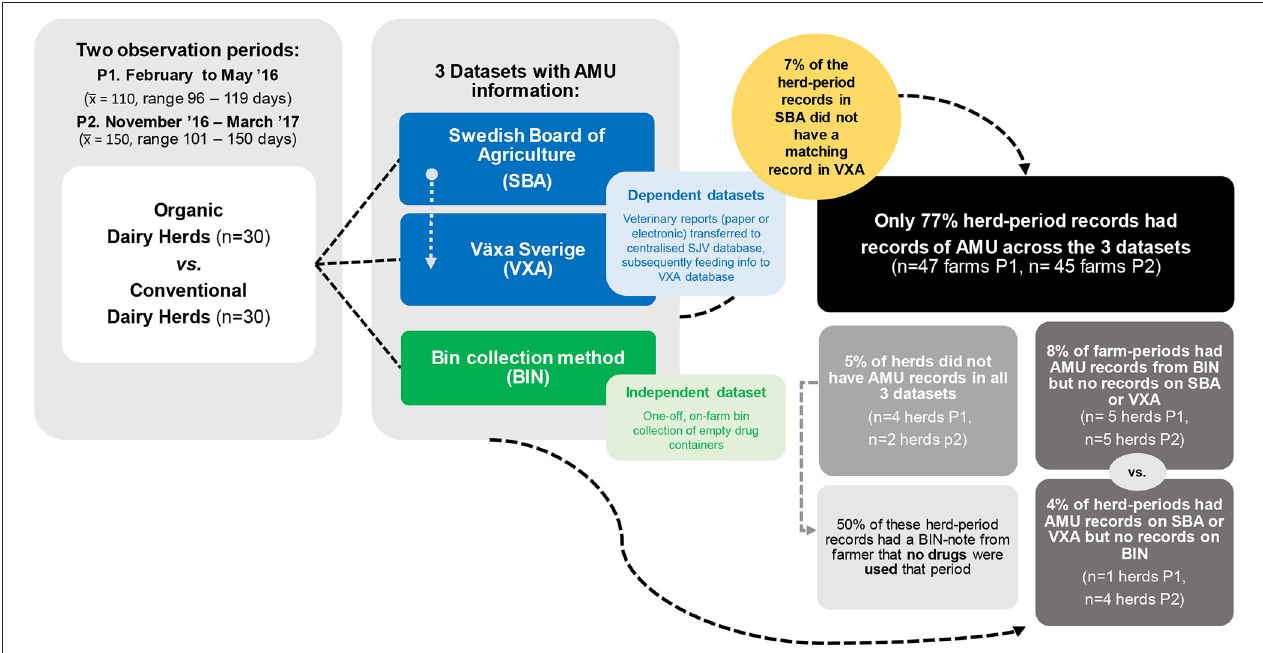
FIGURE 1 | Flow diagram of methodology, dataset relationship, and data availability for antimicrobial use collection for a sample of 30 organic and 30 conventional Swedish dairy herds across two observation periods and as reported by three different datasets.